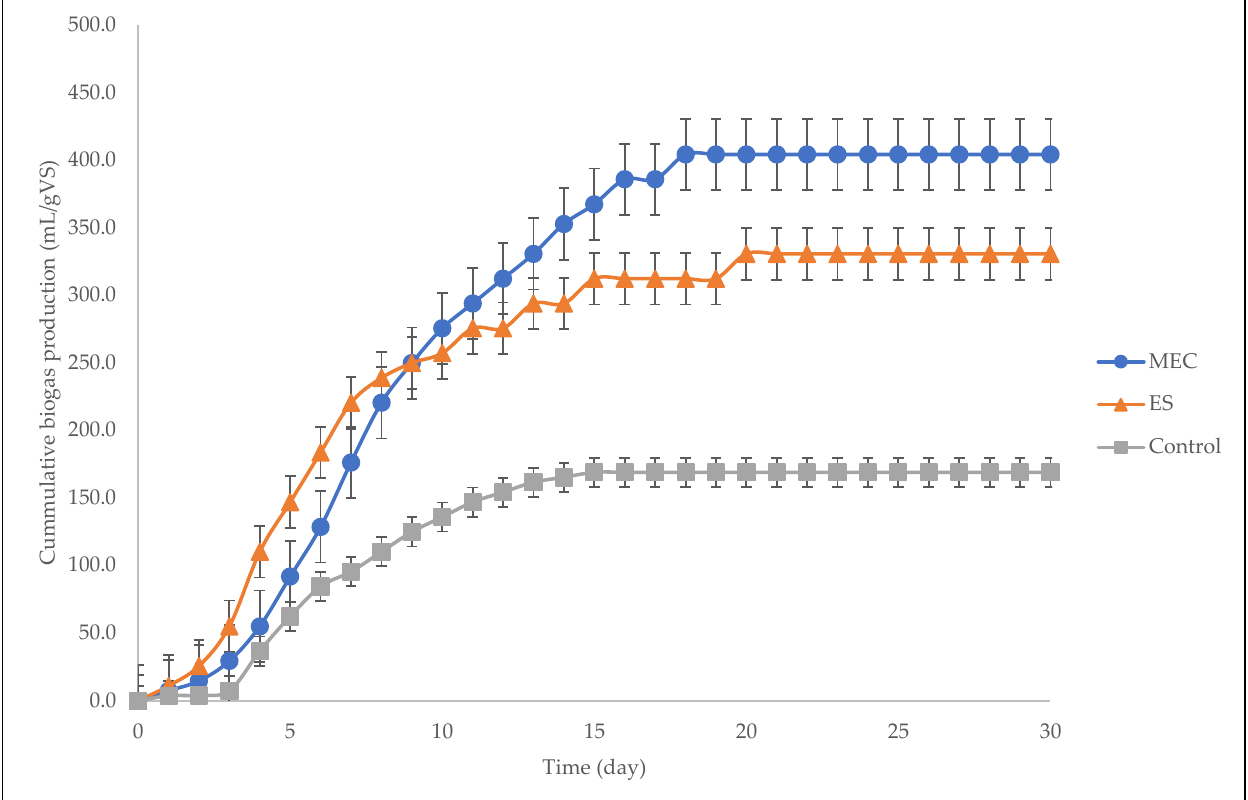
Figure 1. Cumulative biogas production for MEC, ES and control.